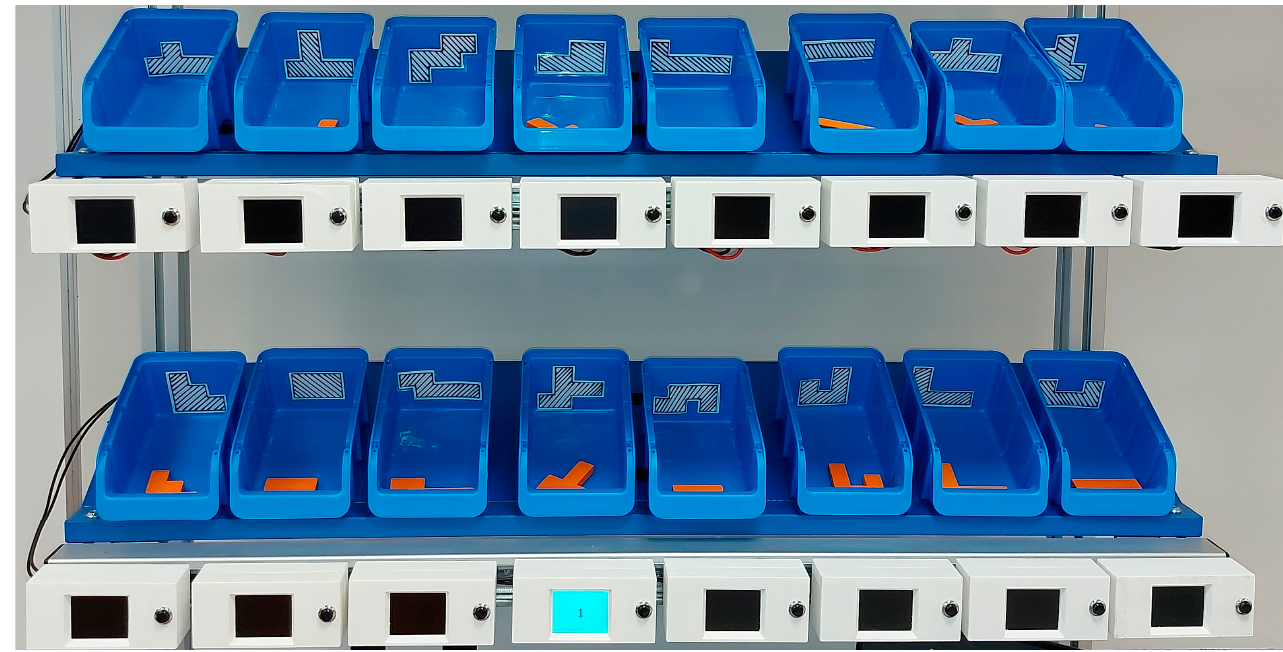
Figure 13. PTL modules (Gillux-Puzzle, solution field 18, step 14/17).